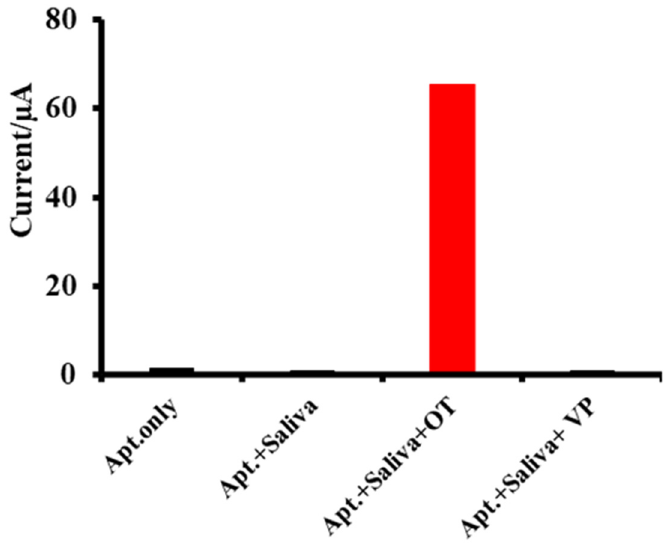
Figure 5. Specificity analysis. 1 µg/mL oxytocin and >100 µg/mL vasopressin (VP) were spiked separately in apparently healthy (control) saliva samples.